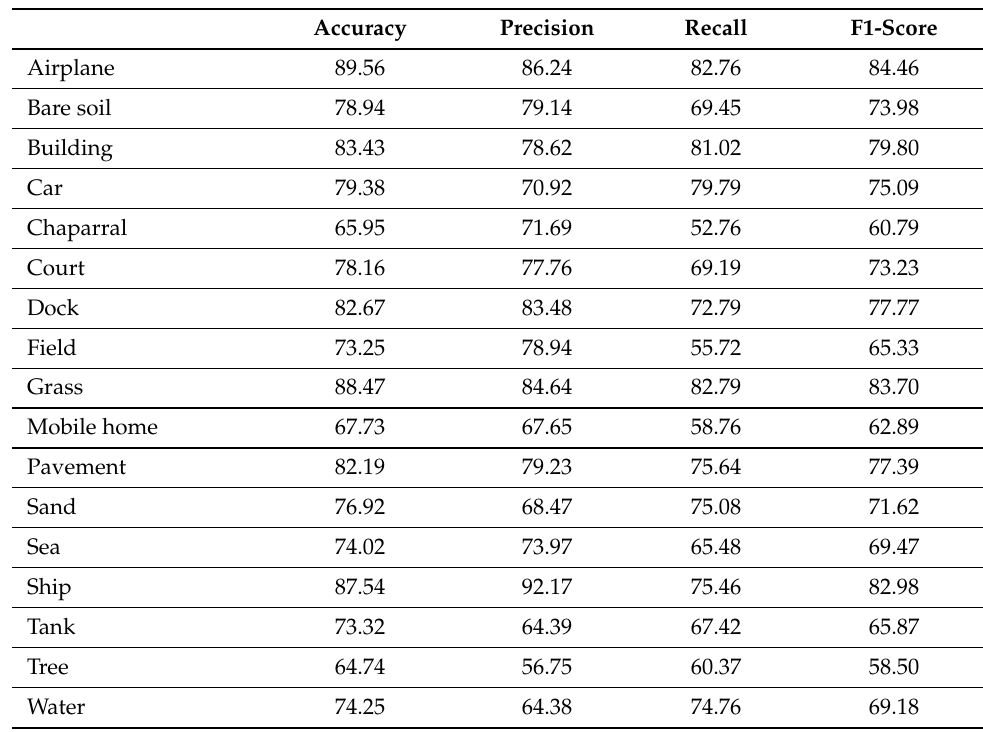
Figure 4. Long-range skip connections vs. no-skip connections. The figure demonstrates the effective- ness of using long-range skip connections to avoid gradient vanishing and accelerate the convergence. Table 4. Class-wise performance of the proposed